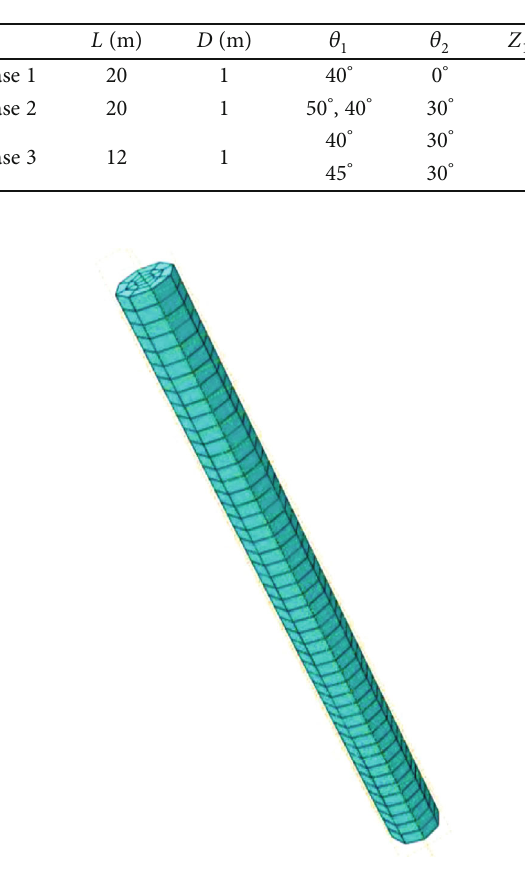
Figure 10: Three-dimensional model of the pile.